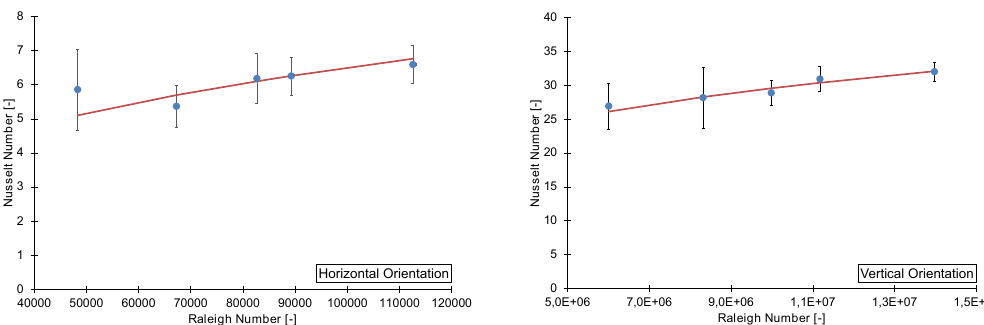
Figure 7. A comparison between a painted flat plate in horizontal and vertical orientation with the correlation found in the literature [29,30].